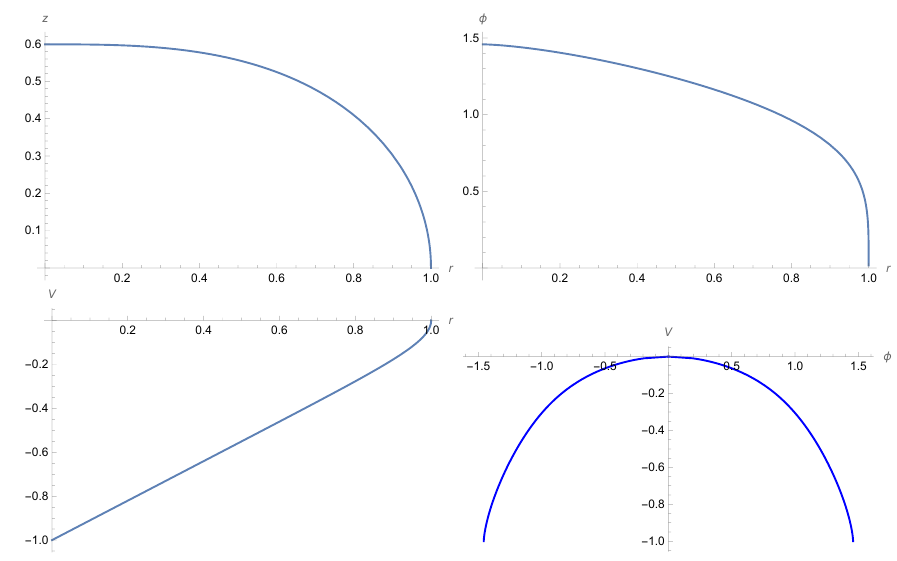
Figure 11 . Configurations with A ( r ) = − r . The upper right, upper left, lower right, and lower left graphs are z ( r ) , φ ( r ) , V ( r ) , and V ( φ ) , respectively. In the fourth plot, because we can not determine the sign of φ , we plot not only ( φ, V ) but also ( − φ, V ) . The quadratic coefficient of V ( φ ) is computed by lim r → 1 V ( r ) /φ ( r ) 2 and is − 0 . 25